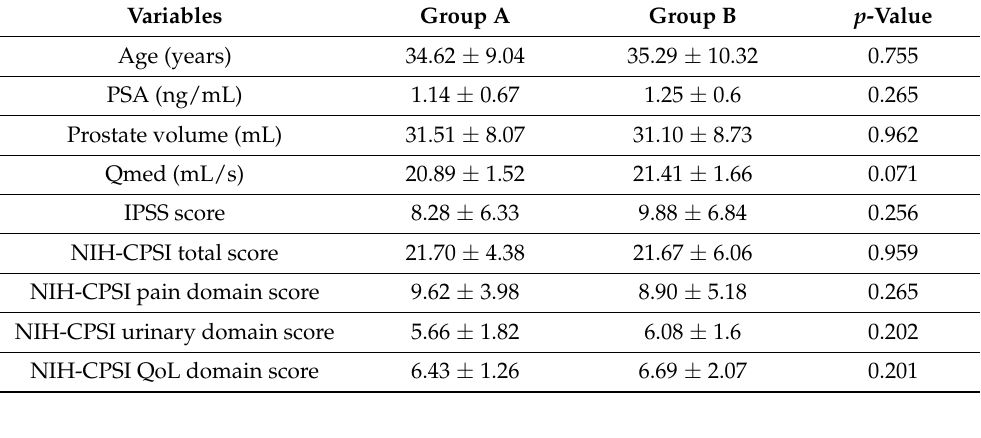
Table 1. Descriptive statistics of patients involved.